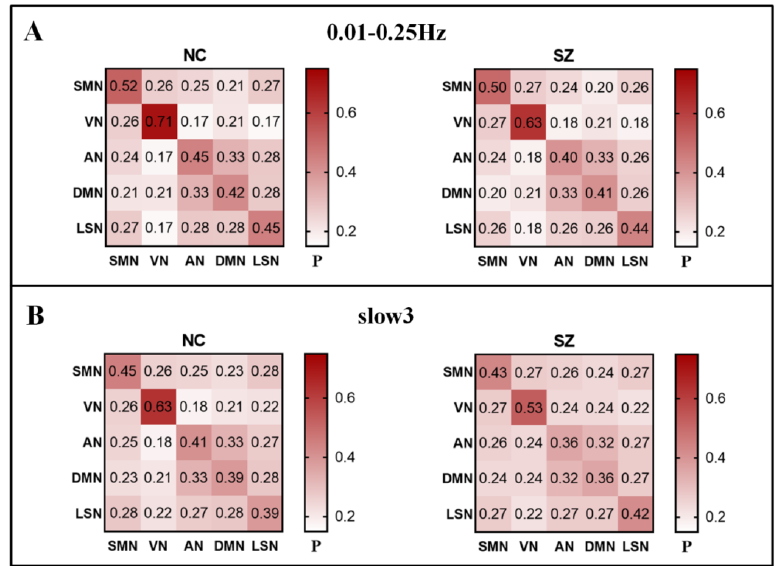
Figure 4. Matrix of module allegiance in NC and SZ. ( A ) full frequency (0.01–0.25 Hz). ( B ) slow3 (0.073–0.198 Hz). P represents the mean value of module allegiance. The main diagonal represents the recruitment coefficient, and the upper/lower triangle represents the integration coefficient.